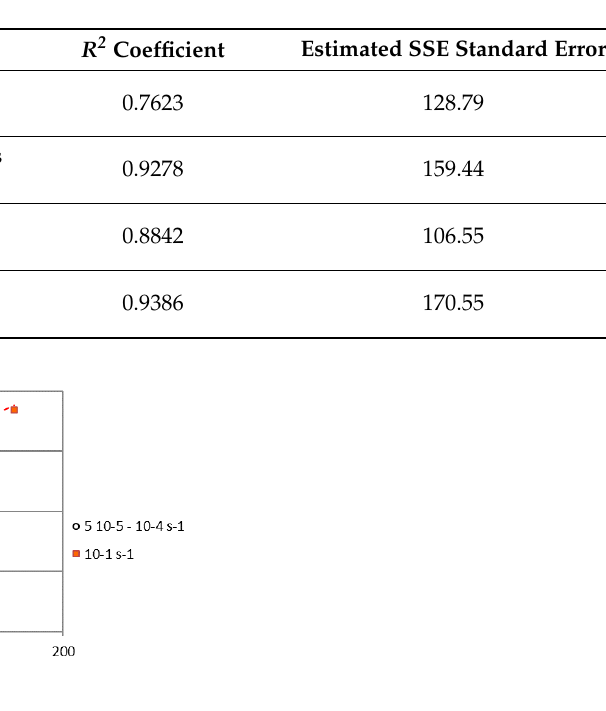
( B ) Figure 6. E st = f (UCS) dependence for hard coals: ( A ) from the Mudstone Series and the Upper Sile- sian Sandstone Series; ( B ) lithotypes vitrain, clarain, and durain. Table 7. Linear regression analysis results of E st = f (UCS) for coals of various geologic age and pet-